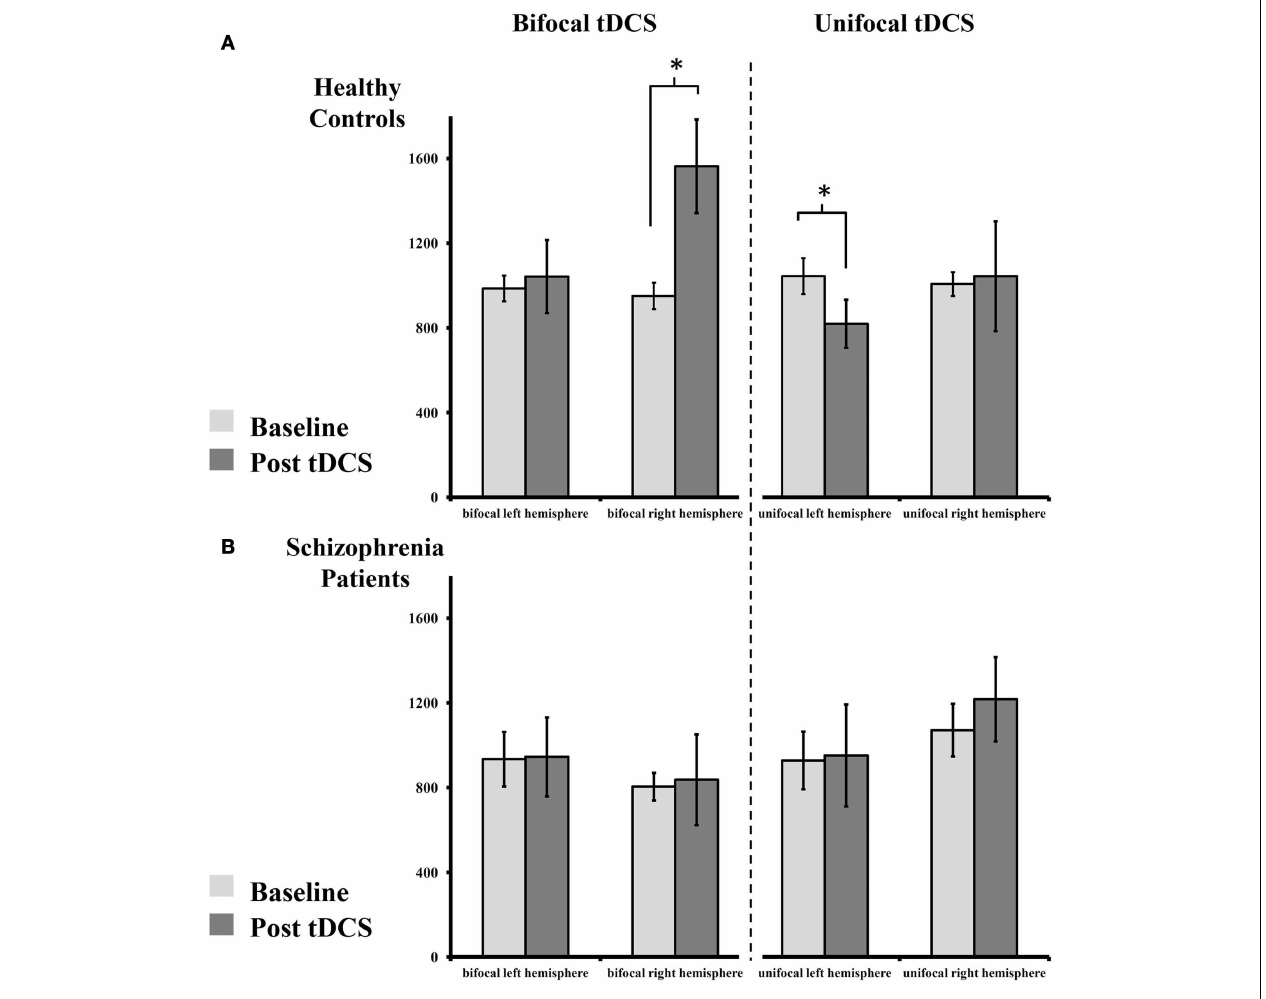
stimulated left, but not on the non-stimulated right hemisphere. (B) Patients with schizophrenia show abolished plasticity following both stimulation paradigms on both hemispheres. For details please see Section